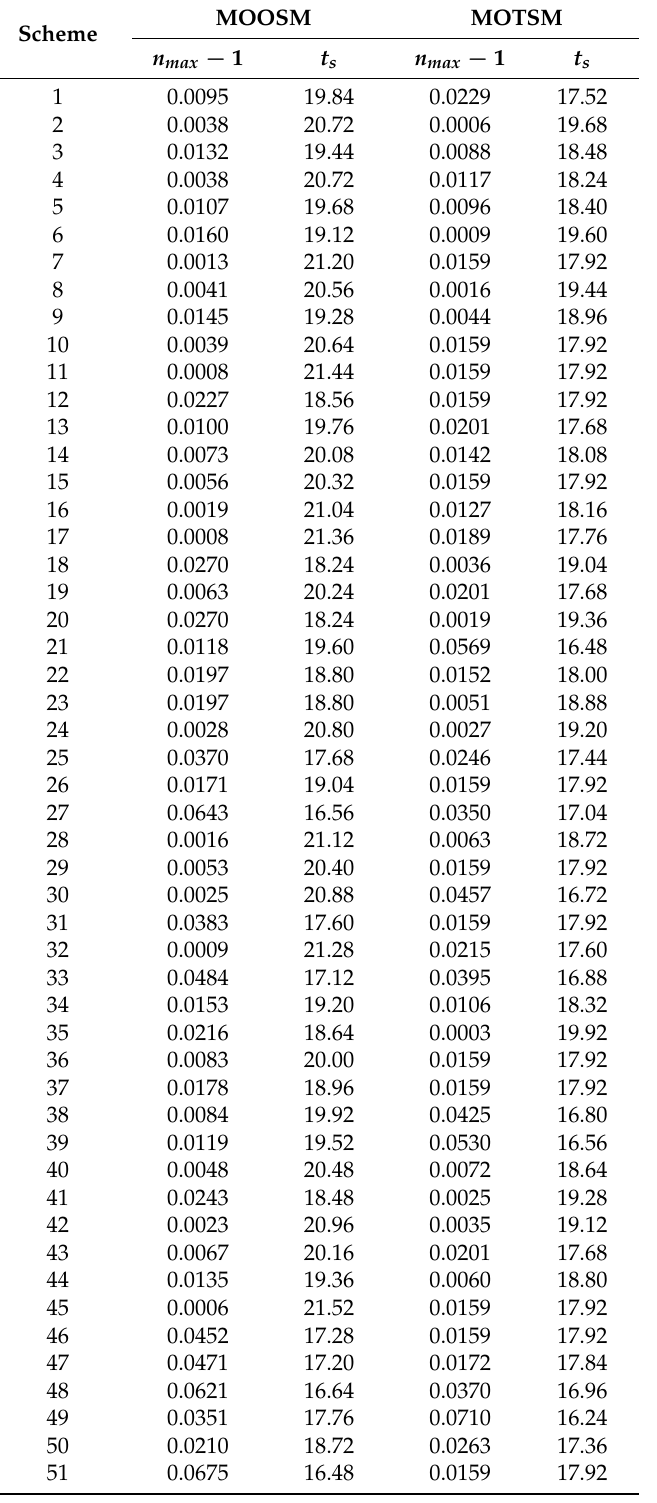
Table A1. Objective functions of the repository